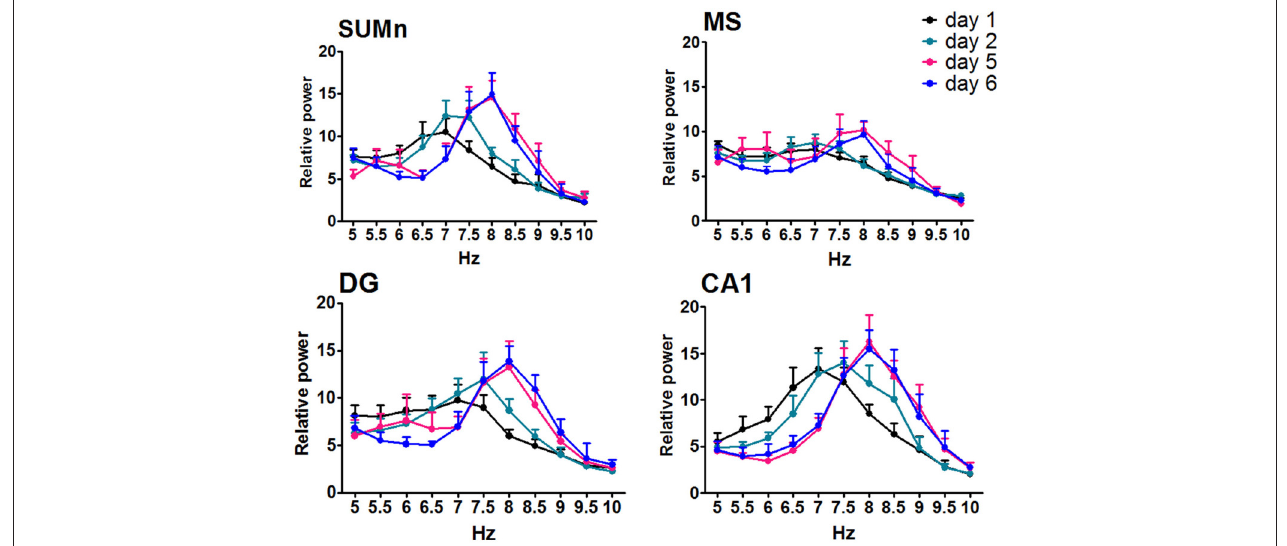
FIGURE 4 | Relative power in the theta band (5–10Hz) recorded in the four regions of the CTR group during the searching of the platform across days of training. Only days 1, 2, and 5, 6 are showed. Mean ± SEM. Significant differences are listed in Table 1 . p < 0.05 .